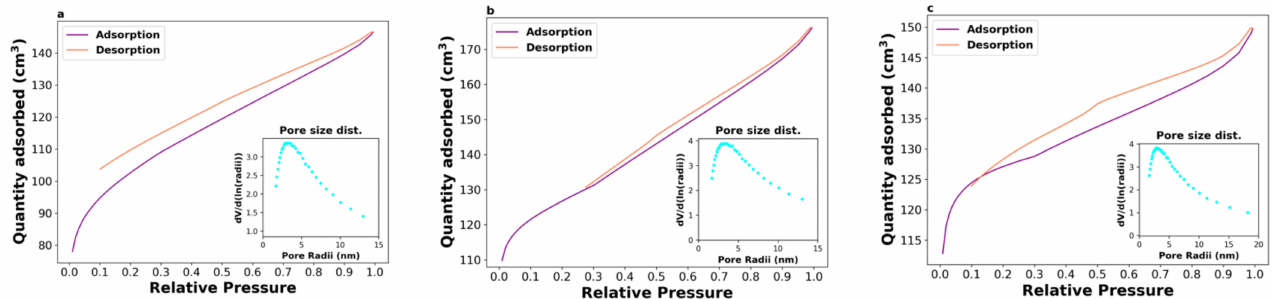
Figure 1. N 2 adsorption–desorption isotherms at 77 K and pore size distribution on: ( a ) CAG, ( b ) Fe/CAG, and ( c )